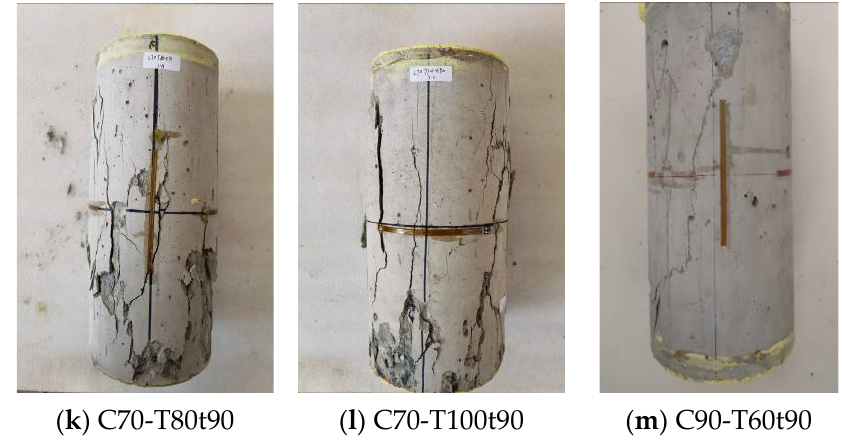
Figure 5. Failure modes of SSC cylinders.